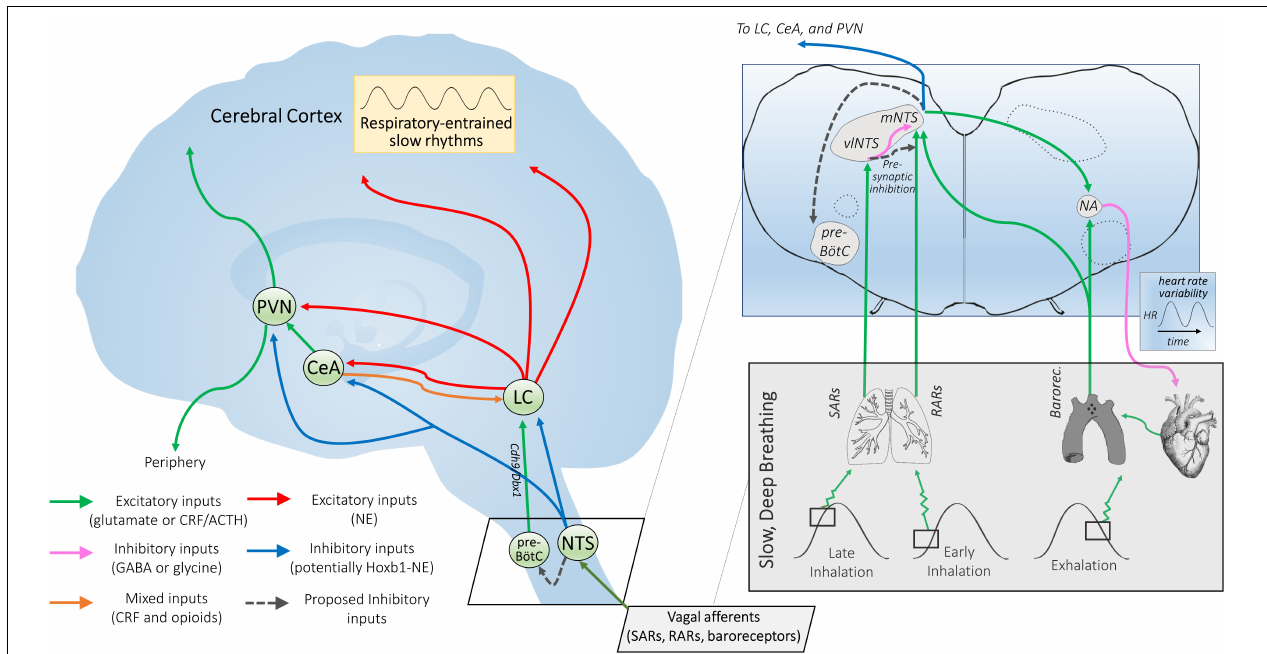
FIGURE 2 | Proposed mechanisms of NTS-mediated relaxation. Inset : Slowly-adapting pulmonary receptor (SAR) and rapidly-adapting pulmonary receptor (RAR) afferents project to the brainstem at the level of the medulla and innervate the parasympathetic relay nucleus, i.e., the nucleus of the solitary tract (NTS). That SARs project to a distinct anatomical NTS subregion from RARs and baroreceptors and are associated with a differentiable respiratory phenotype (slow and deep) is consistent with SARs serving a distinct function via a state transition in brainstem autonomic signaling. SARs project primarily to GABAergic inhibitory neurons in the ventrolateral subregion of the NTS (vlNTS) (Berger and Dick, 1987; Kubin et al., 2006), while RARs provide input to the more medial and caudal regions of the NTS (mNTS) (Kubin et al., 2006) to recruit noradrenergic output pathways. Aortic arch and carotid sinus baroreceptor primary afferents mimic RARs in their NTS termination patterns (Dean and Seagard, 1995), but are activated during exhalation instead of inhalation ( Figure 1 ). Glutamatergic projections from the NTS are poised to regulate nucleus ambiguus (NA) cardiac vagal neurons (Neff et al., 1998). The ipsilateral mNTS is the major brain area sending projections to the cardioinhibitory region of the NA (Stuesse and Fish, 1984); though direct projections from the vlNTS have been observed, these are apparently less numerous and have not been shown for sake of clarity. Note that although projections from baroreceptor afferents to the NTS and the NTS to NA appear to cross contralaterally, this is for simplicity of illustration; the majority of these projections are ipsilateral. NTS projections may also feed in to the pre-Bötzinger complex (pre-BötC), potentially inactivating Cdh9/Dbx1 pre-BötC neurons that appear to activate the locus coeruleus (LC) via glutamatergic projections (Yackle et al., 2017; Vann et al., 2018), and thereby promoting calming. Outset : NTS projections to the central nucleus of the amygdala (CeA), paraventricular nucleus of the hypothalamus (PVN), and LC may link cardiorespiratory afferent activation to the effects of slow, deep breathing on stress reduction and attention. Noradrenergic NTS neurons project to downstream limbic areas, sending branching collaterals to the CeA and PVN (Petrov et al., 1993). Several nuclei in the NTS (along with the CeA) also project to the LC, potentially modulating central norepinephrine release (Van Bockstaele et al., 1996, 1999; Berridge and Waterhouse, 2003). NTS projections may serve to integrate autonomic responses with this circuitry and influence downstream targets of the LC (Van Bockstaele et al., 1999). The LC also provides noradrenergic projections to the CeA and PVN (Petrov et al., 1993), supporting the possibility of further signal integration at these higher-order hubs of the central autonomic network. Hoxb1 noradrenergic neurons (some of which originate from the NTS) provide a substantial input to the LC and peri-LC dendritic field (Chen et al., 2018) and are one neuronal subpopulation that could potently modulate LC activity, contributing to NTS-mediated relaxation. Interconnectivity between the two arms of this proposed neural pathway could influence peripheral and central release of neuropeptides through the PVN and widespread noradrenergic modulation of forebrain areas through the LC that together may impact arousal and responsiveness to